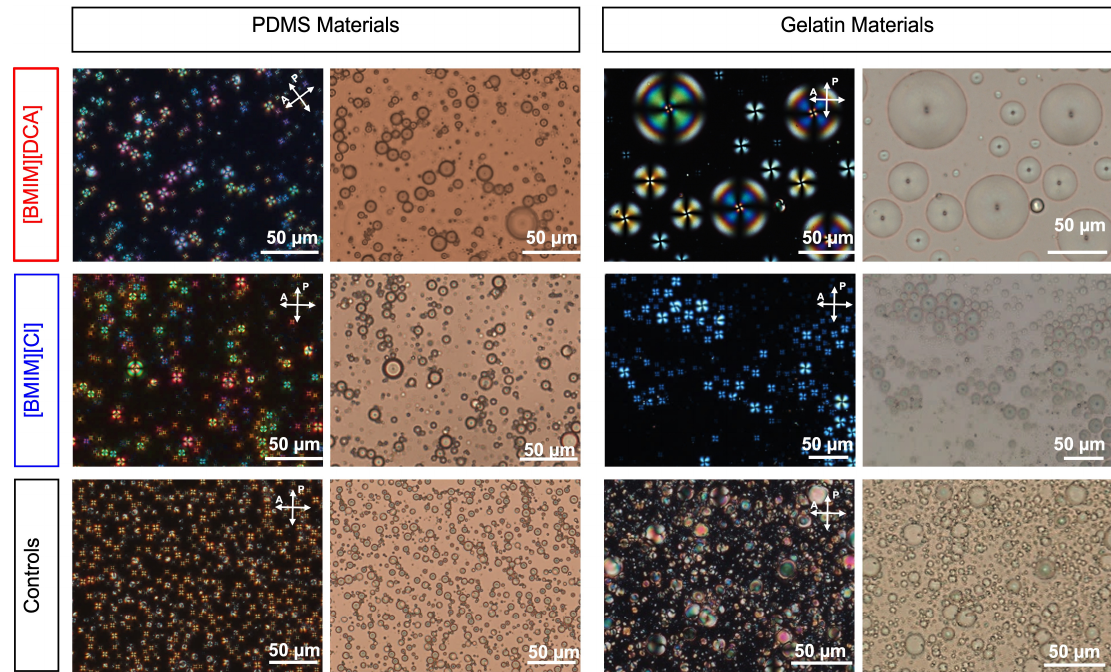
Figure 2. Examples of polarized optical microscopy (POM) images of optically active areas obtained for the sensing films under crossed polarizers (left columns) and bright field (right columns).